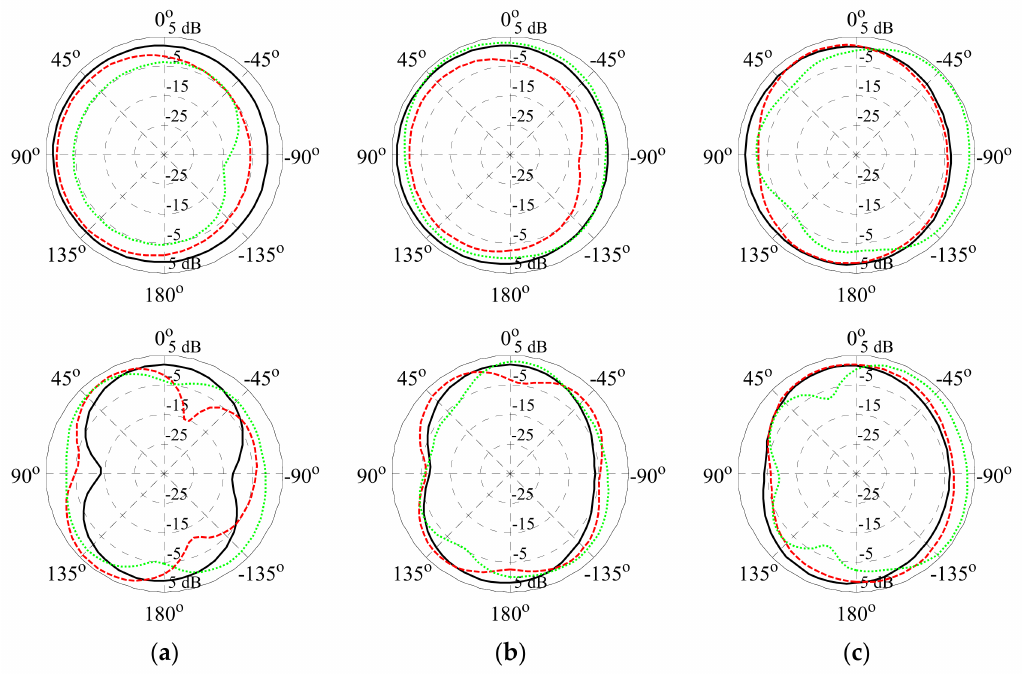
Figure 10. Realized gain patterns obtained at 4 GHz (–), 7 GHz (- -), and 10 GHz ( ··· ) for the optimized antenna designs ( a ) x 1.20* , ( b ) x 5.20 * , and ( c ) x 9.12* . The top and bottom plots represent the characteristics obtained in the x–y and x–z planes (see Figure 9), respectively.